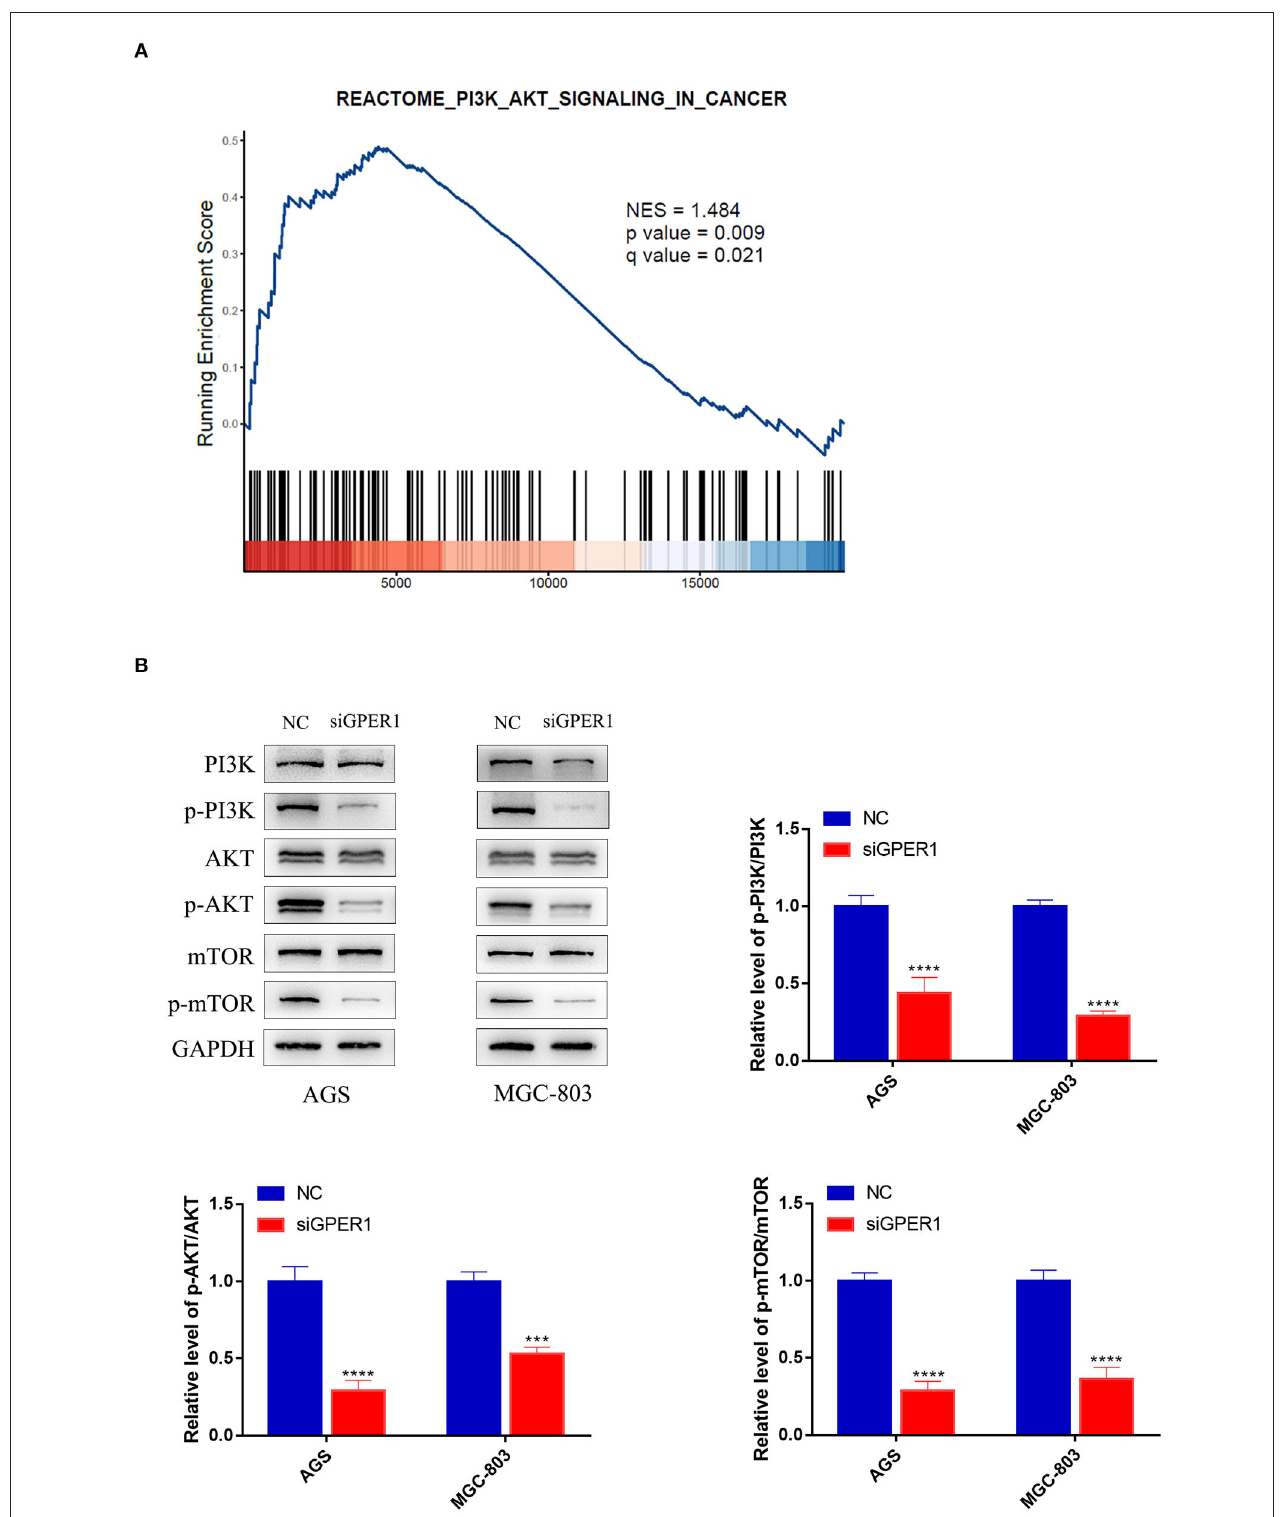
FIGURE 2 | GPER1 is a regulator of the PI3K/AKT pathway. (A) Gene Set Enrichment Analysis evaluating GPER1 expression and the PI3K/AKT_SIGNALING pathway in gastric cancer; (B) Western blot analysis of p-PI3K, PI3K, p-AKT, AKT, p-mTOR, and mTOR protein expression in AGS and MGC-803 cells transfected with GPER1 siRNA. Results were shown as mean ± SD of three independent experiments, each experiment was performed in triplicate. *** P < 0.001; **** P < 0.0001.